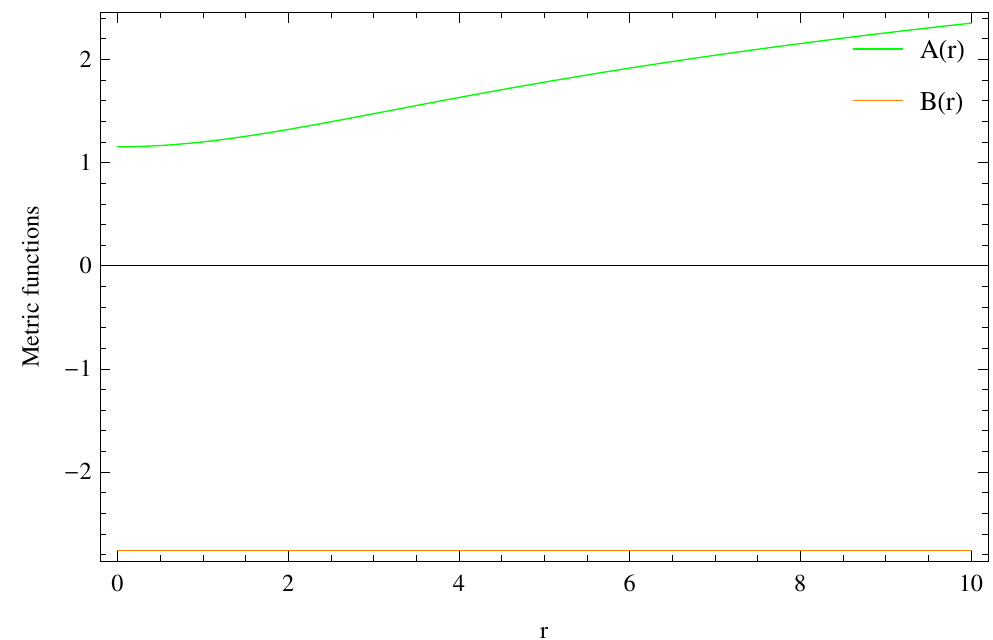
Figure 17. The metric functions are plotted against the radial parameter r with the values of the arbitrary constants ω = 1, λ = 0.1, C 4 = 0.001, C 5 = 10, C 6 = 1.